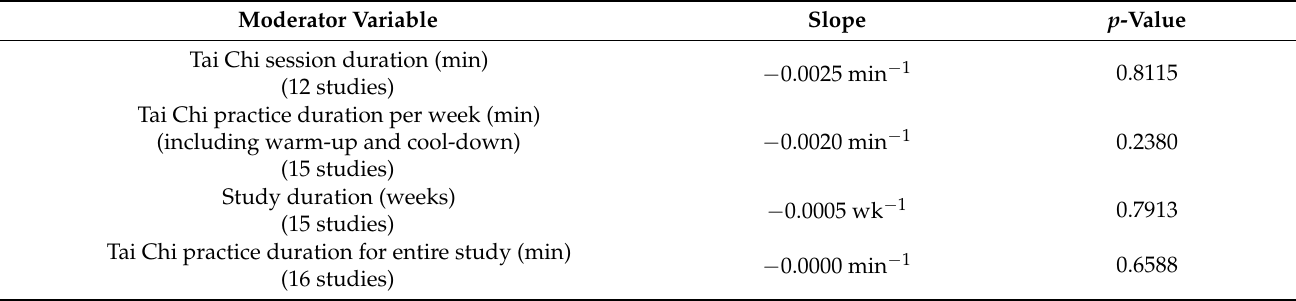
Table 3. Summary of meta-regression analysis examining moderator variables that might explain between-study variance in effect size.